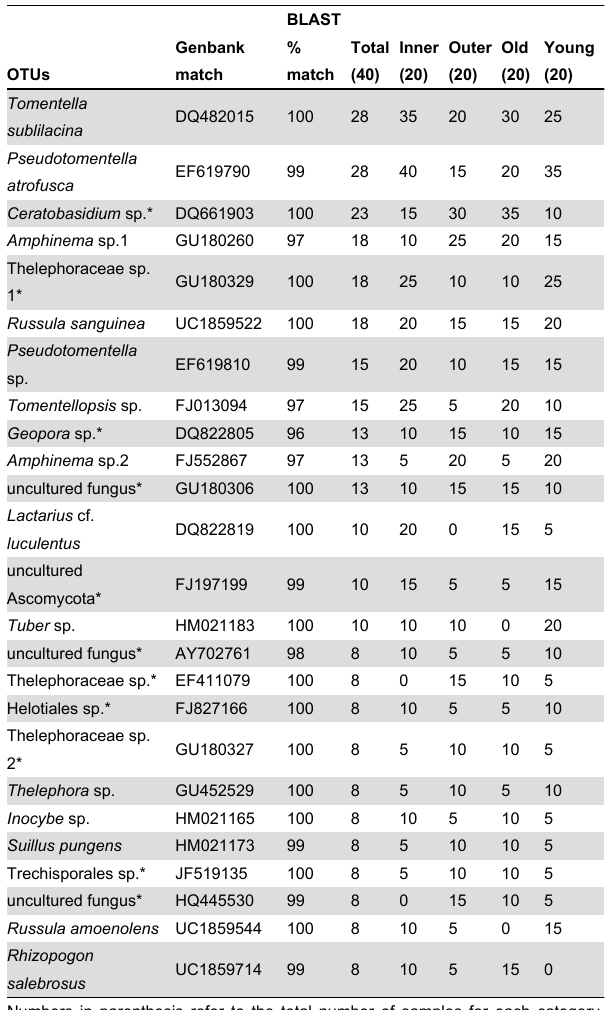
Numbers in parenthesis refer to the total number of samples for each category. Unidentified OTUs marked with a * were good matches to fungi recovered from EM root tips in GenBank and therefore considered